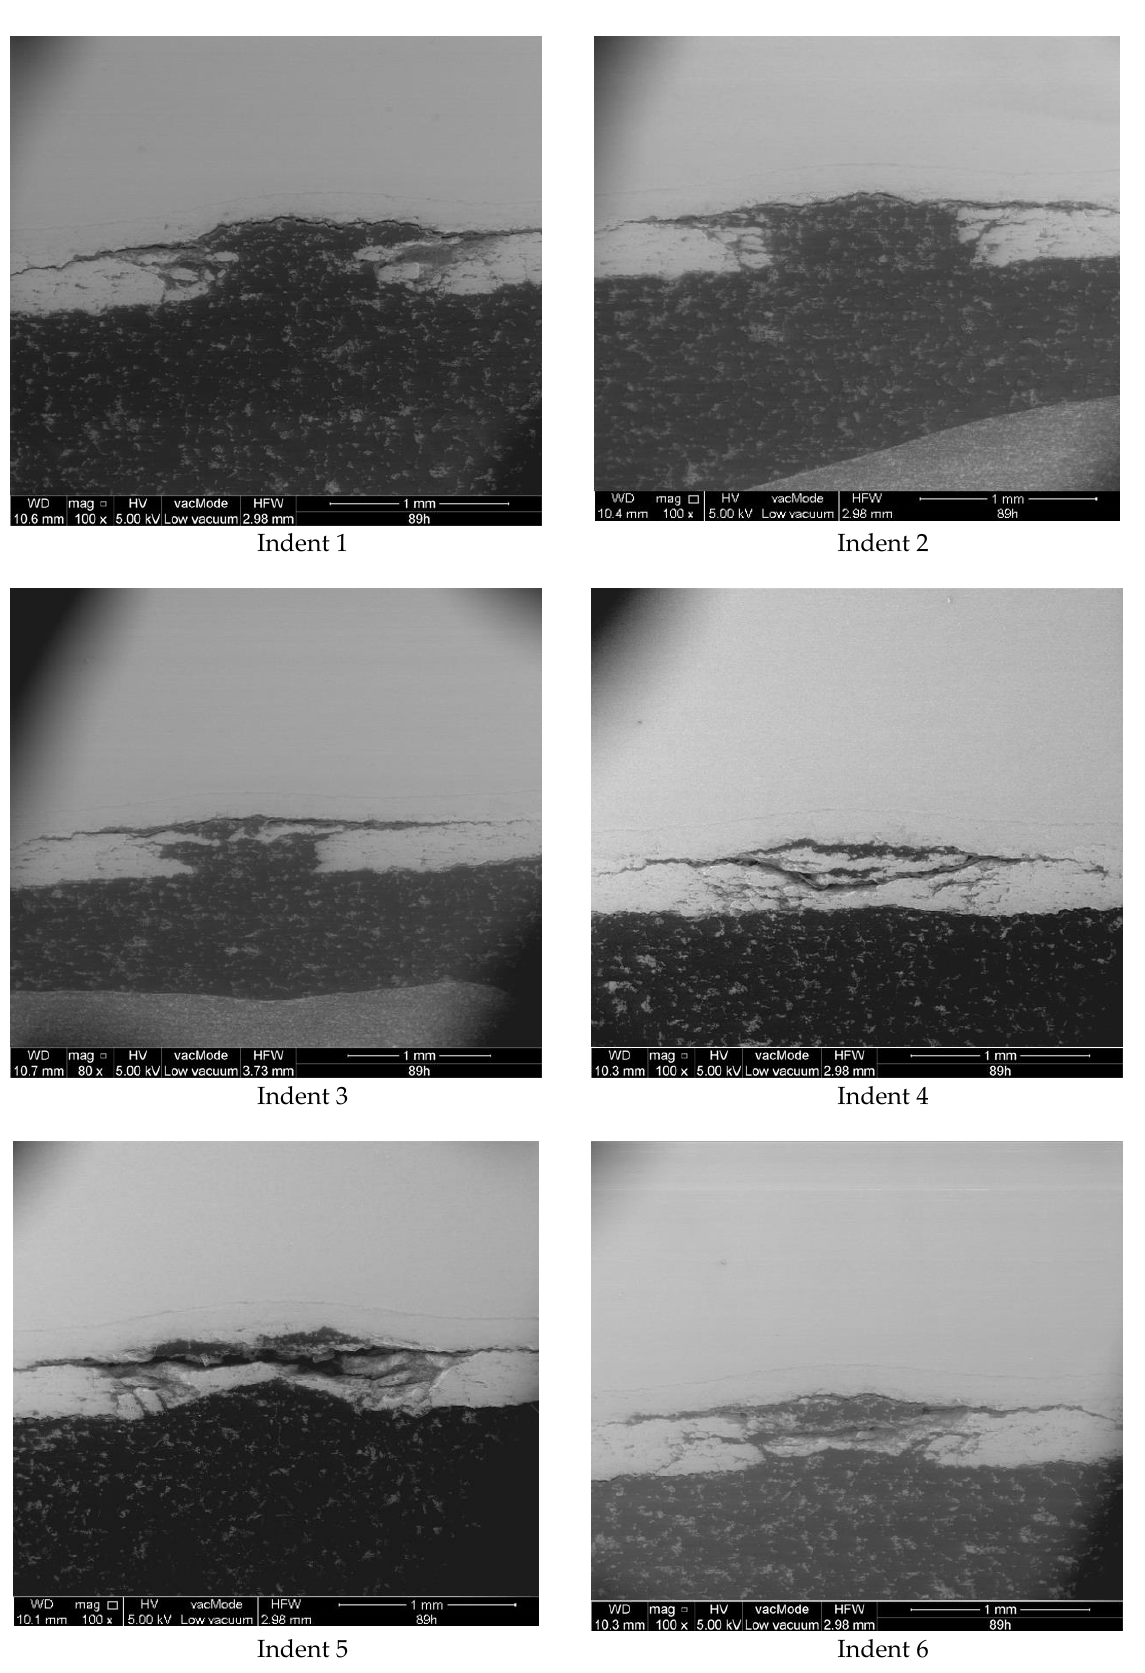
Figure 5. Images of indents for the aging time set to 89 h and different speeds.